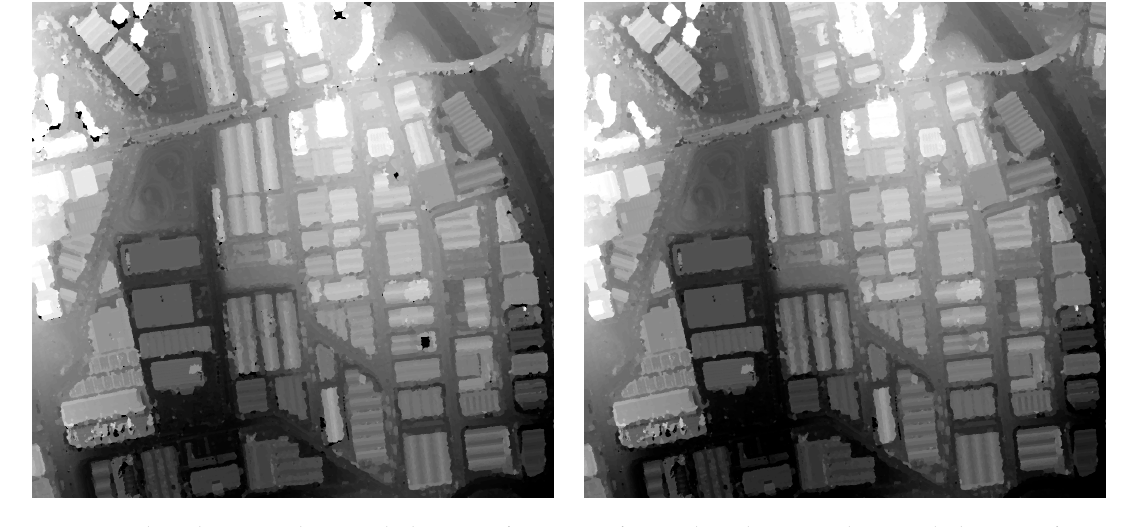
Figure 13. DSMs according to increasing search distances. IDW—inverse distance weight.